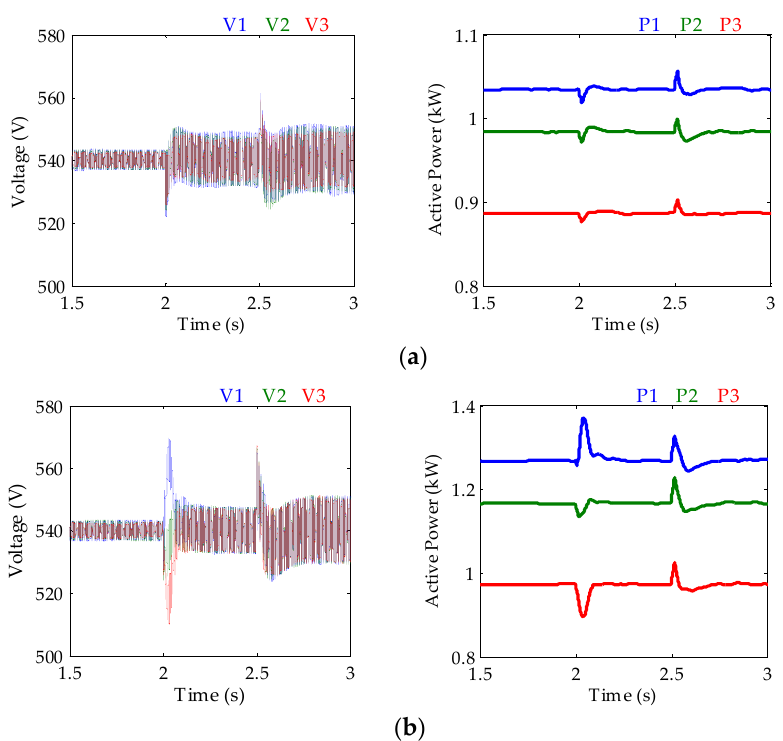
Figure 9. Simulation waveforms of dc-link voltage and the active power of CHBR modules under different working conditions by the use of ( a ) the proposed control strategy and ( b ) the conventional control strategy.